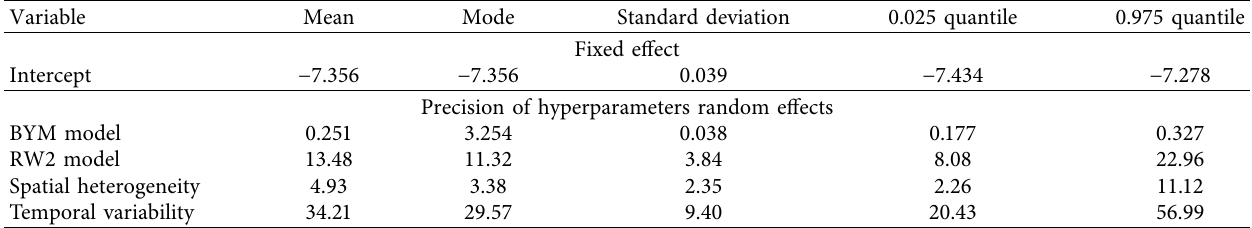
Table 4: Nonparametric dynamic trend estimate of malaria incidence in northwest Ethiopia between 2012 and 2020.